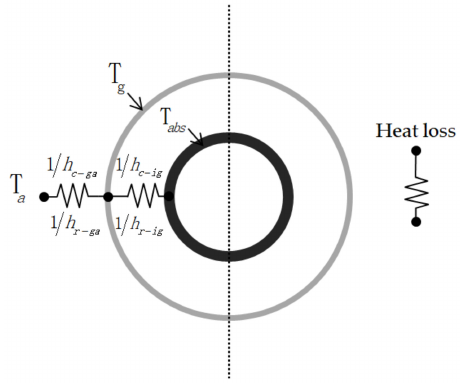
Figure 9. Heat loss of a single